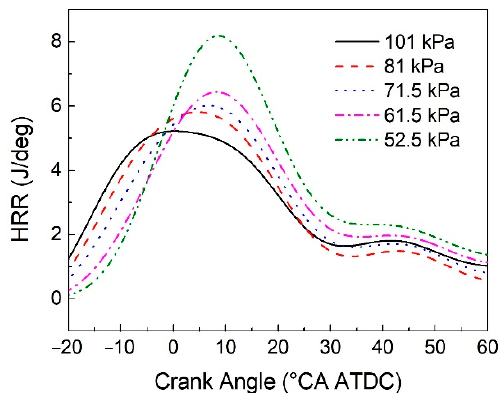
Figure 7. Heat release rate under the various MAPs.